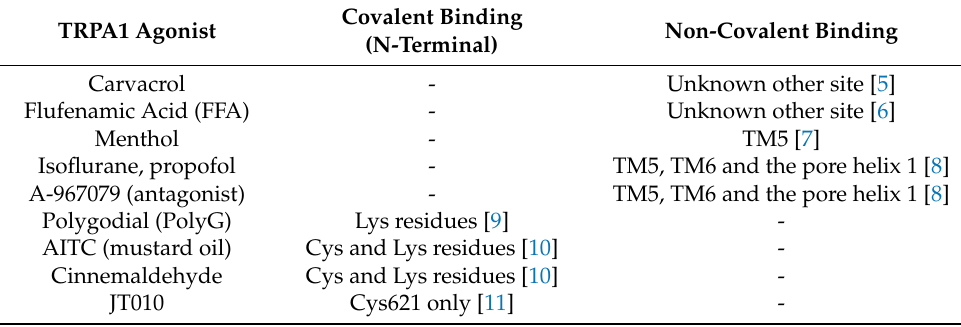
Table 1. TRPA1 agonist binding